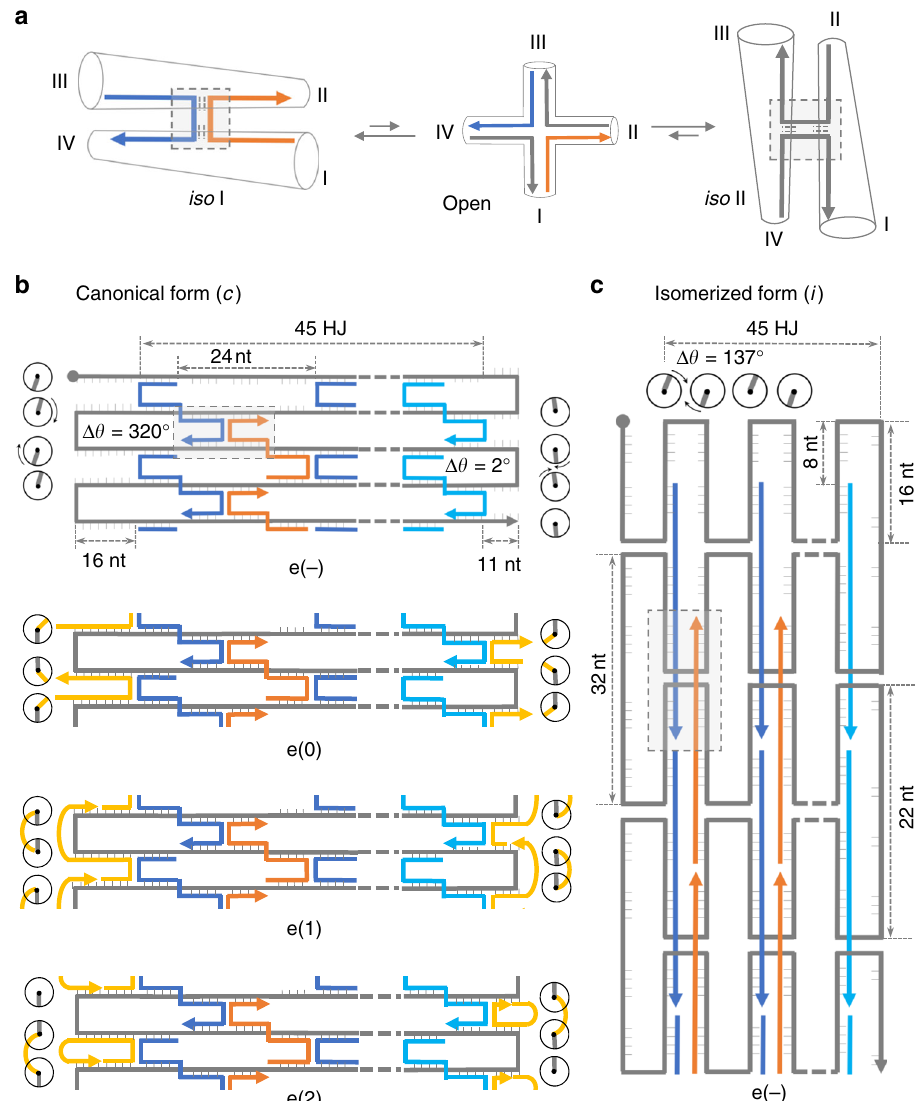
Fig. 1 Design of three quasi-independent DNA origami domains. a In presence of magnesium ions, the Holliday junction (HJ) displays two isoforms, characterized by pairwise coaxial stacking of arms into a right-handed antiparallel stacked X-structure, with arms I/IV and III/II stacked in iso I and II/I, IV/ III stacked in iso II. The interconversion between the two isomers passes through a less stable open intermediate, where the four helical arms point towards the corners of a square. Global iso I ( b ) and iso II ( c ) conformation of the HJs constituting a DNA origami domain and corresponding to the canonical ( c ) and isomerized ( i ) shape of the structure. In the iso I isomer the lateral loops are 32 nt- and 22 nt-long, respectively, at the left- and right-side of each domain, whereas 24 nt-long stretches of the unpaired scaffold are located at the top and bottom of each domain (e( − ) construct). In the iso II form, instead, every domain adopts an “ inverted ” con fi guration, in which the HJs of the core (blue and orange strands) are fl anked by lateral stretches and vertical loops of the unpaired scaffold ( c ). Note the last row of staples on the right-side of each domain (cyan strands): Although forming 32 bp-long duplexes, their secondary structure is partially constrained into a loop by a parallel stretch of unpaired scaffold that is 10 nt shorter. Both the left- and right- side of each domain have been addressed with three types of edges (yellow strands, in the e(0), e(1), and e(2) constructs), differing in the mechanical strain applied at the points of scaffold inversion. Circular symbols indicate the relative orientations of the bases at the helical edges (scaffold and staple bases are in gray and yellow, respectively). The angular displacement from the ideal situation in which the two scaffold bases are aligned and face each other (0°) denotes the degree of torsional stress generated by the hybridization of edge